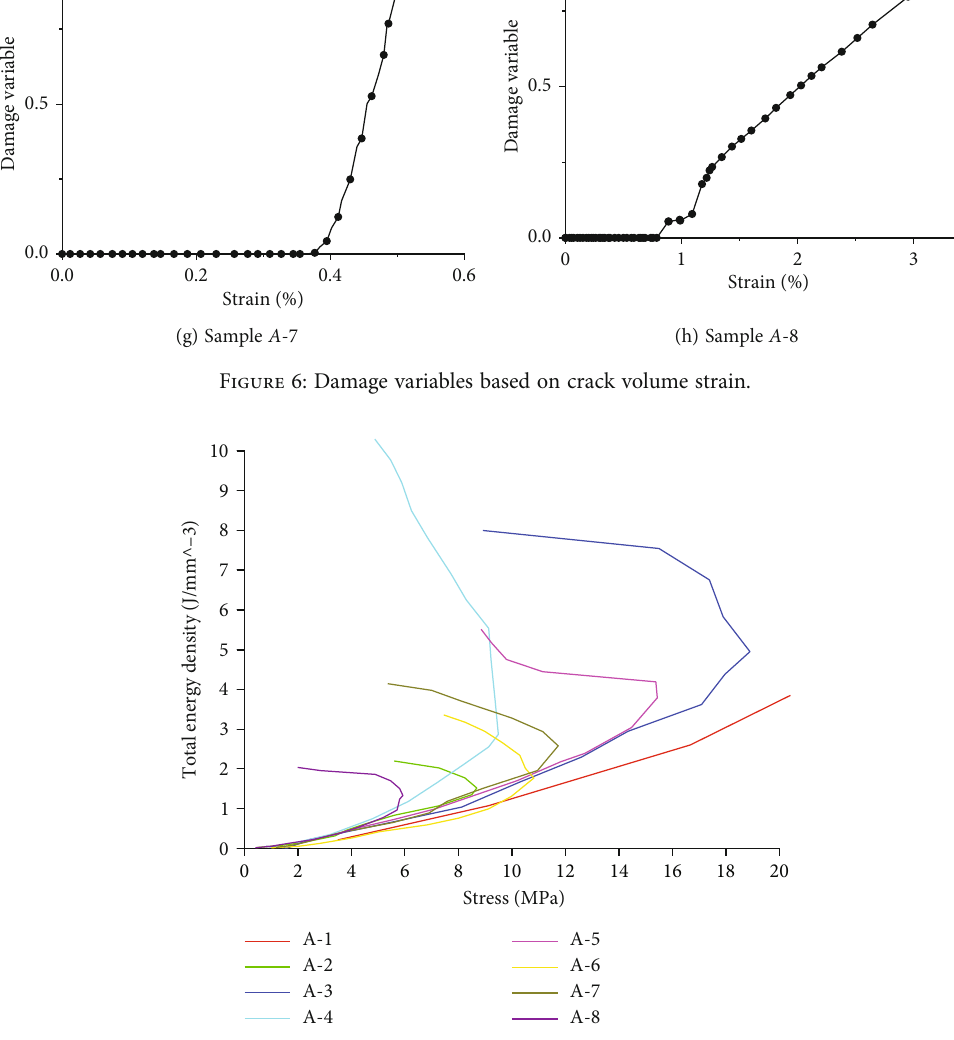
Figure 7: Evolution curve of total energy density and axial stress of